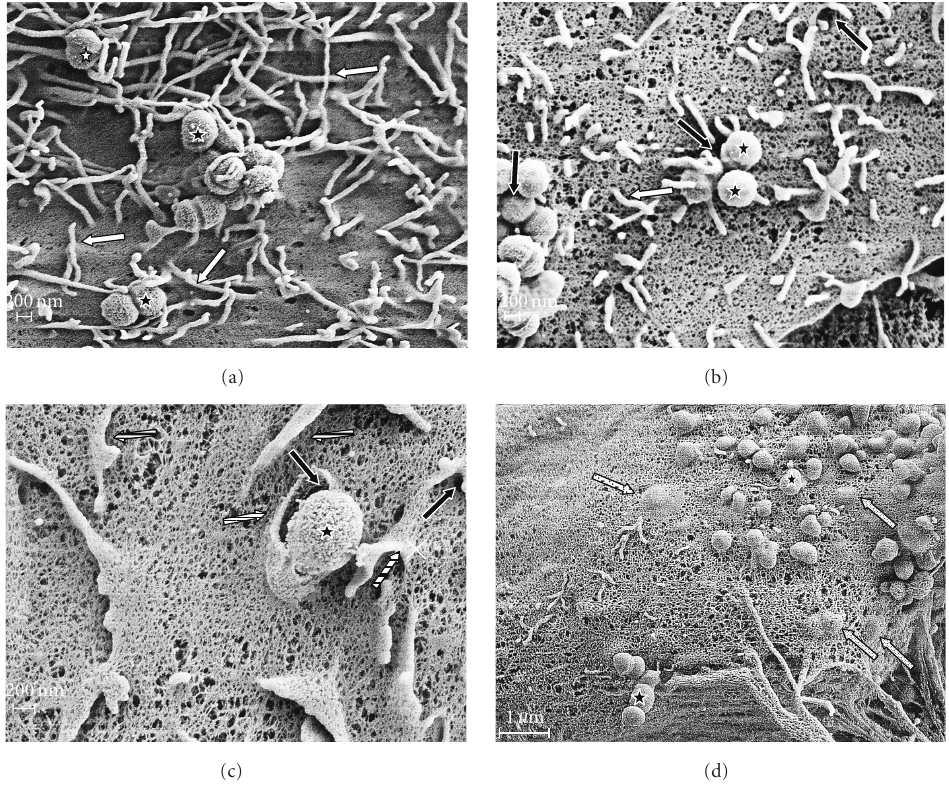
Figure 5: Scanning electron microscopy (SEM) of cocultures of bovine mammary epithelial cells with host-proteins pre-treated S. uberis . Streptococcus uberis was pre-treated with collagen, fibronectin, or lactoferrin and cocultured with bovine mammary epithelial cells. Cocultures were observed using SEM at di ff erent incubation times. Upon contact with S. uberis ( ∗ ) bovine mammary epithelial cells reacted (a) with the formation of plasma membrane invaginations (black arrows) and “spaghetti like” filopodia (white arrows) that stick to and covered (b) S. uberis formations of more than one cell. Filopodia then seemed to become flap-like structures (striped arrows) that engulfed single S. uberis cells (c) and drove their internalization into host cells through cell membrane invaginations. The internalization process seemed to end with the “patching” of cell membrane invaginations through which S. uberis gained access into the host cell (dot-filled arrows (d)) with flap-like